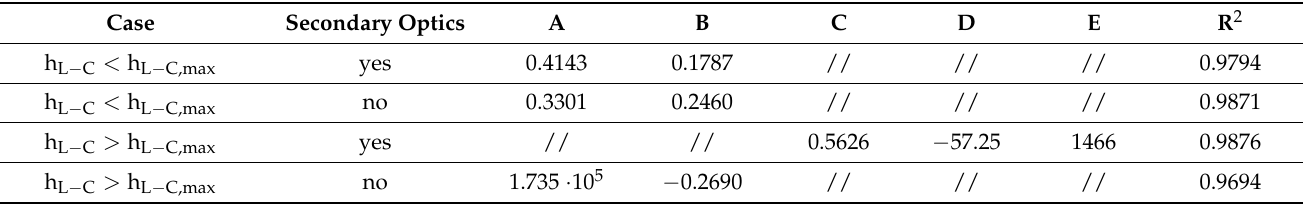
Table 2. Values of the coefficients of the experimental equations describing the trends of C opt for the Fresnel lens.